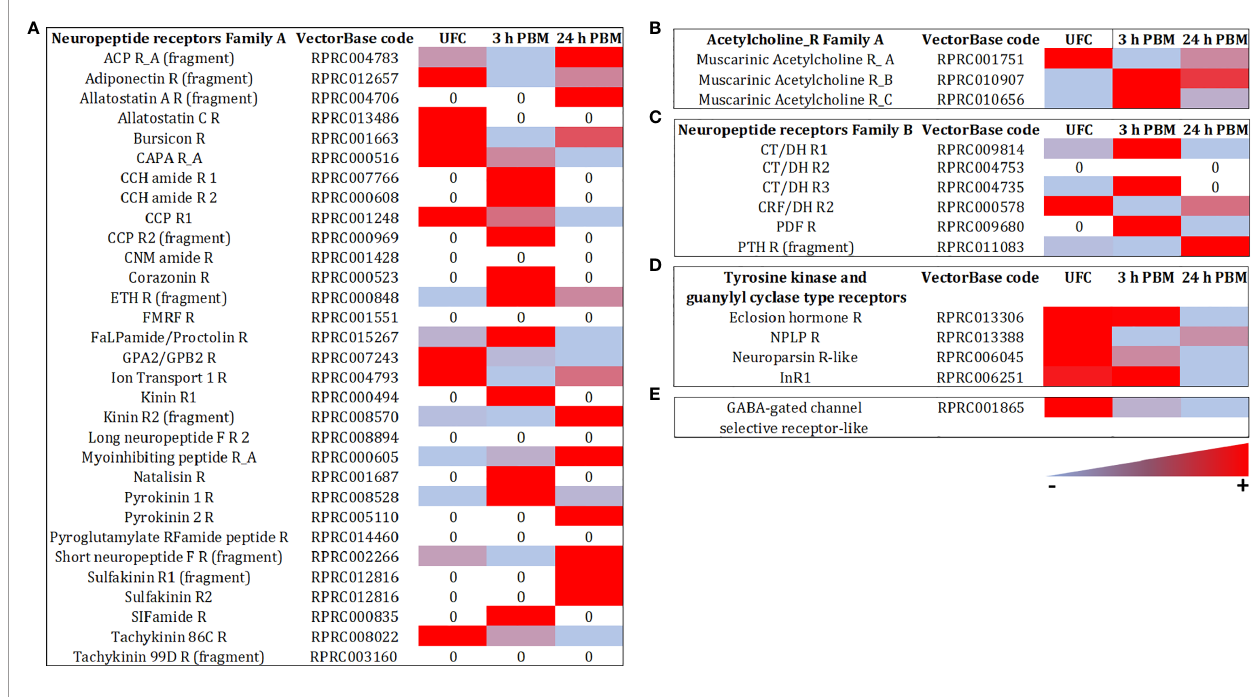
FIGURE 6 | Heat map comparing the mRNA expression levels of (A) Neuropeptide receptors family A, (B) Acetylcholine receptors family A, (C) Neuropeptide receptors family B, (D) Tyrosine kinase and guanylyl cyclase type receptors, and (E) GABA-gated channel selective receptor-like in Malpighian tubule from insects unfed (UFC), 3 h and 24 h post blood meal (PBM). The input data is the readcount value from gene expression level analysis after normalization and is presented using a color scale, in which light blue/red represent lowest/highest expression. DESeq was used to perform the analysis. Details of transcript expression are shown in Supplementary Worksheets 1 , 2